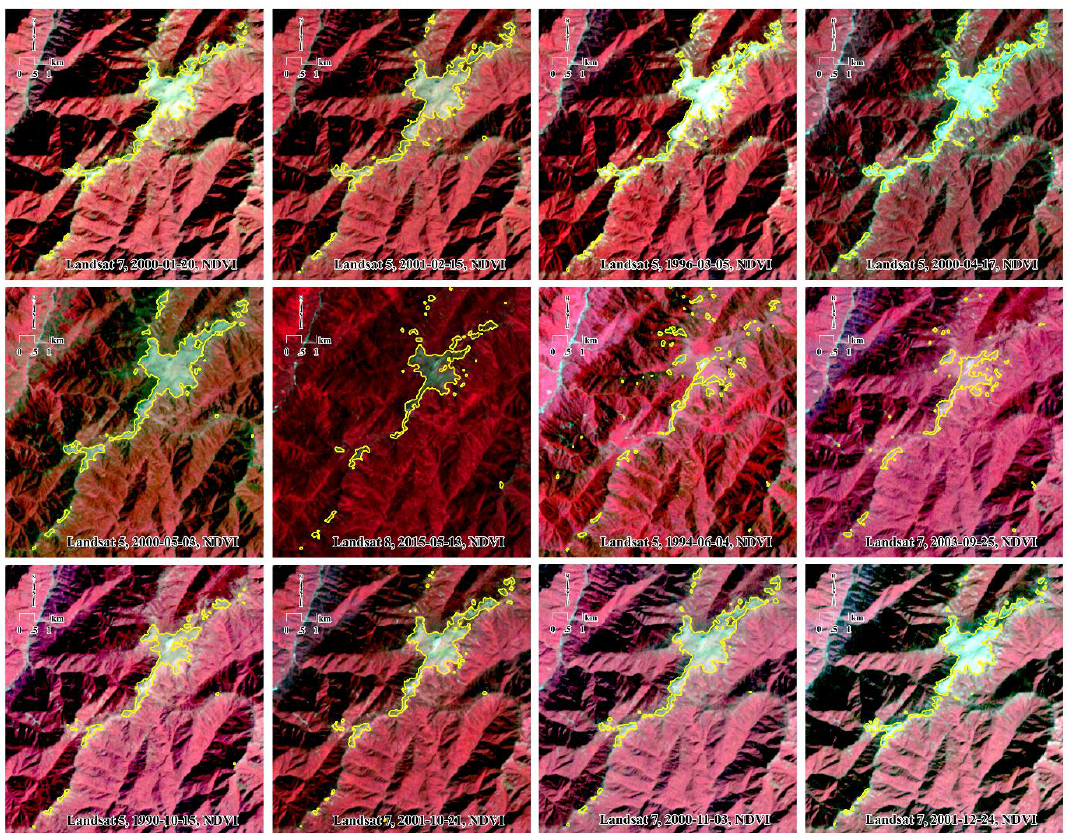
Figure 6. Seasonal variation of automatic tree line extraction. The area of the alpine meadow was not extracted from images acquired from June to September because this was its maximum growing season. The extracted area in the image acquired on 13 May was smaller than that from the 3 May image because grass started to green up in this interval. The extracted area in the images increased from 25 September to 21 October because this was the senescent vegetation period of the alpine meadow.